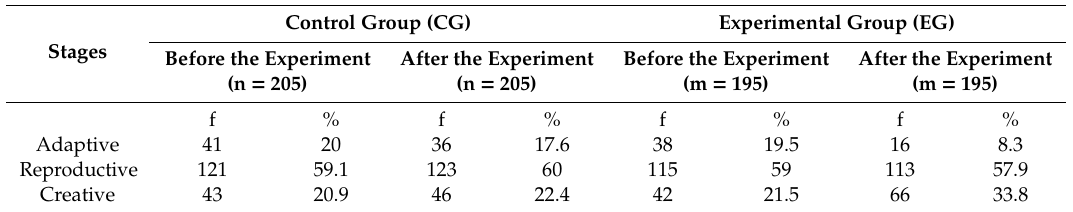
Table 1. Dynamics of future educators’ professional training of introducing social